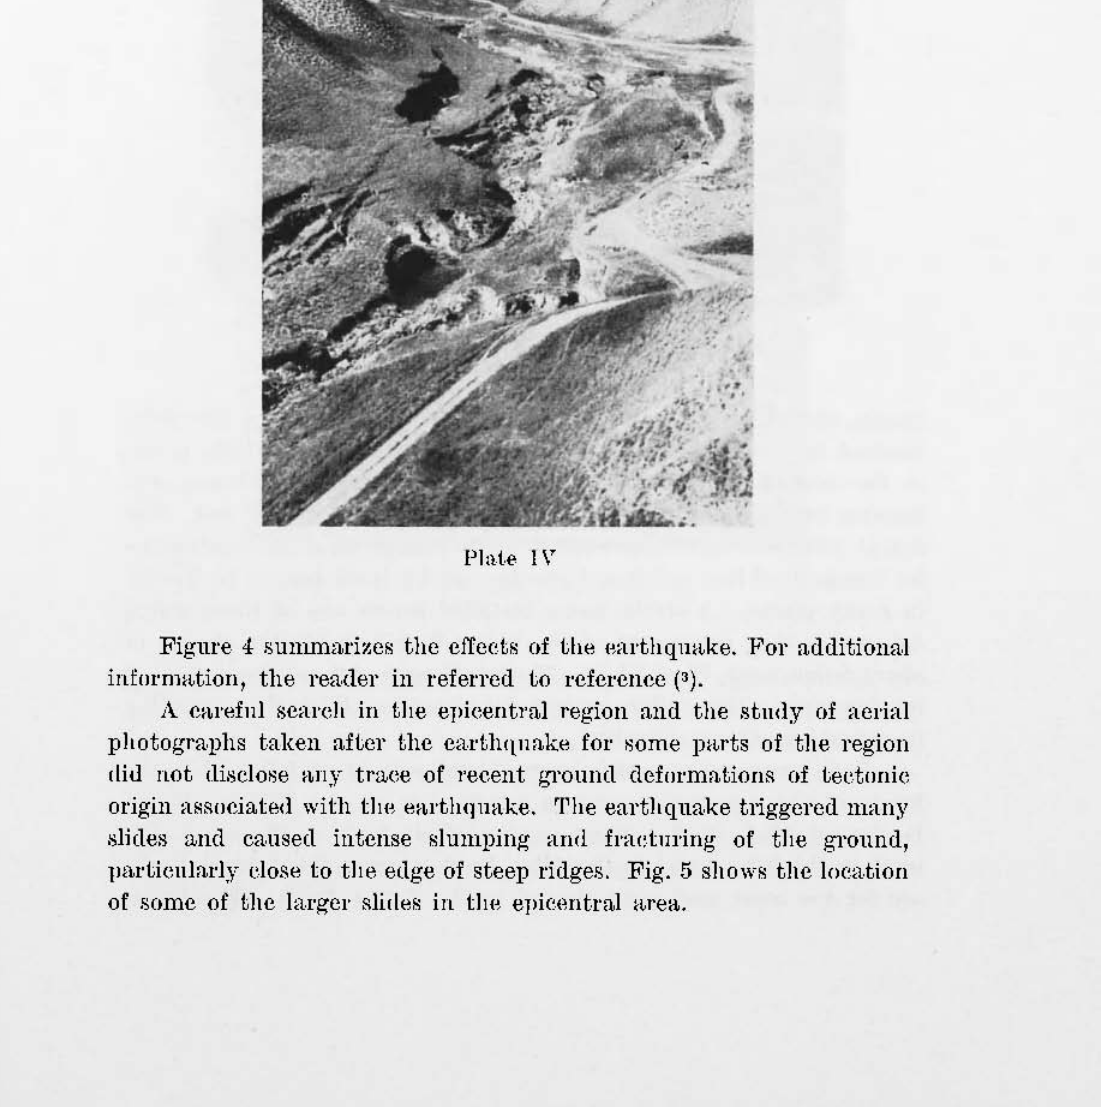
Figure 4 sunllllarizcs thc eJ1cets of Lhe eal'thq1Hòke. Por additi Olmi infornmtion, the rea.der in referrcd Lo referenec (3). A_ eareflll seareh in the epieentml regiOlI and the stlldy of acrial photogra.phs taken after the earthqllake for Home p,òrts of the region diù not diHcloHe ally tra.ee or l'eeent 6'1'OUlHl cleformationR of teetonie origin aSRoeiated with the eartIHj1Hlke. '1'he earthqnake tIiggered lllany Hlides ancl ca.used intense sJulllping and fradllring of the ground, ll!1.rLielllarly dORe to the edge of steep ridges. Fig. 5 shows the loeation or some of the lal'ger Rlides in the epielmt.ml